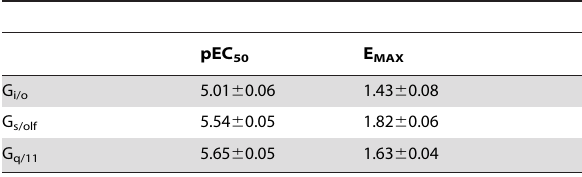
Table 7. Stimulation of [ 35 S]GTP c S binding by carbachol via M 2 receptors to G i/o , G s/olf and G q/11 subtypes of G-proteins in membranes with reduced expression of the G i/o subclass of G-